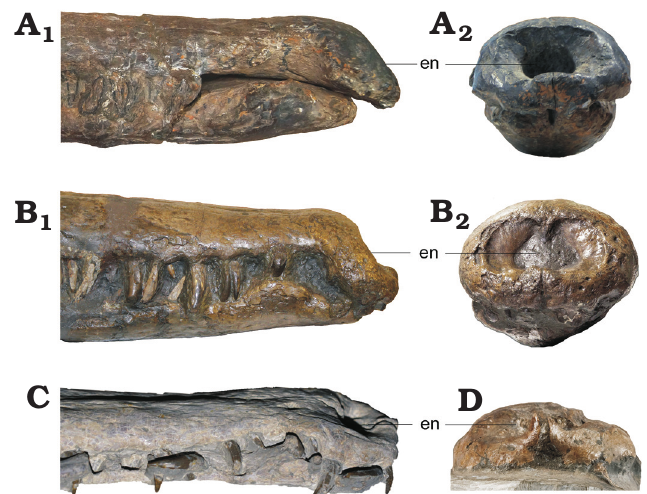
Fig. 3. Comparison between teleosauroid thalattosuchians Mystriosaurus laurillardi Kaup, 1834 (HLMD V946-948, holotype), lower Toarcian of Altdorf (southern Germany) ( A ), Mystriosaurus laurillardi Kaup, 1834 (NHMUK PV OR 14781, holotype of Steneosaurus brevior Blake, 1876, lower Toarcian of Whitby (Yorkshire, UK) ( B ), and Steneosaurus bollen- sis (Jäger, 1828) (PMU R161, RE 551.762.130 A 0248), lower Toarcian of Holzmaden (southwestern Germany) ( C , D , respectively). Anterior portion of rostrum in lateral (A 1 , B 1 , C) and anterior (A 2 , B 2 , D) views, showing the ventrally deflected premaxilla and the anteriorly facing external naris (en). Not to